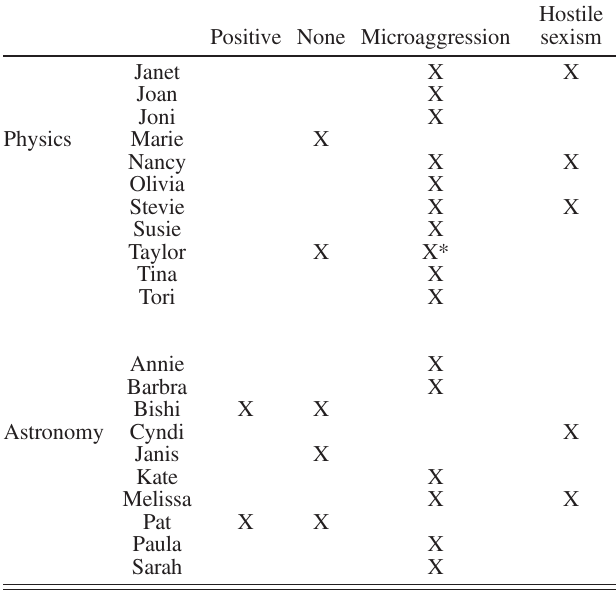
TABLE I. Gendered